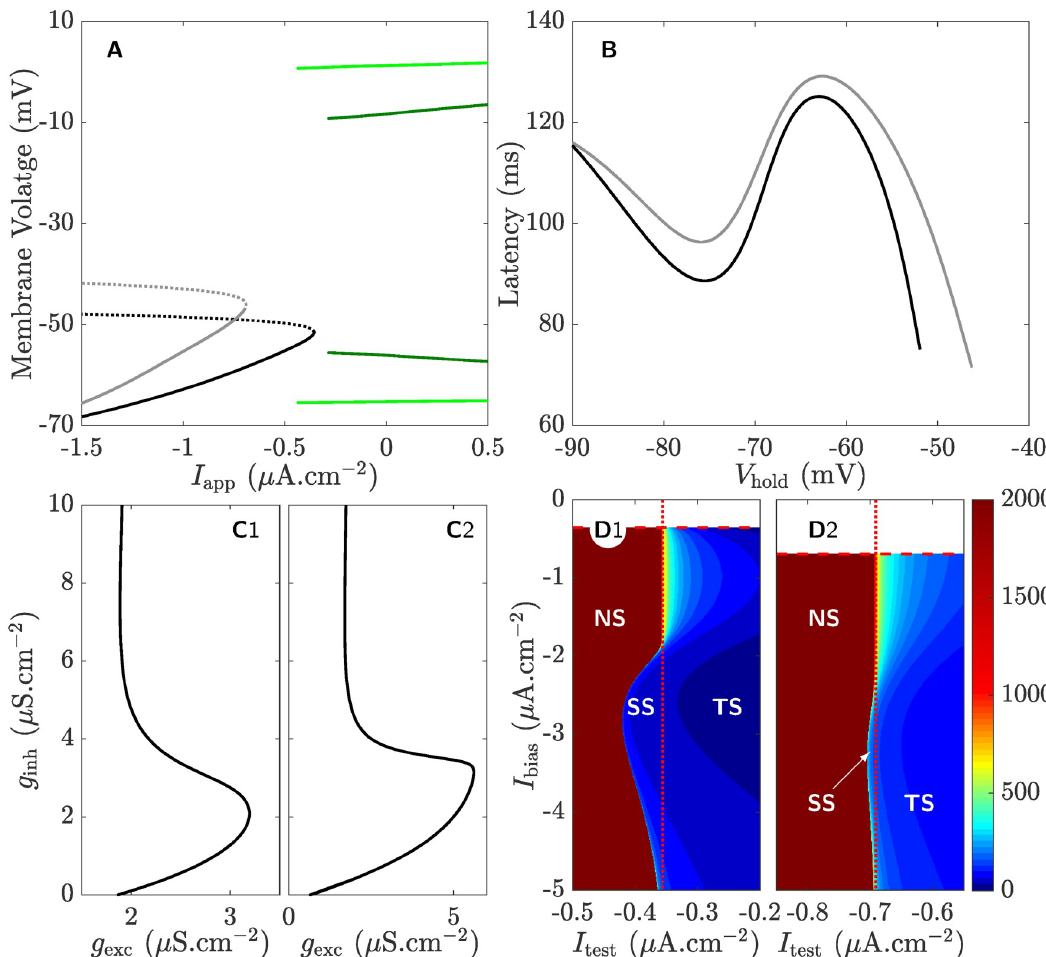
Fig 2. Review of the main four features of the full system (1): A ) Type I excitability with a SNIC bifurcation during pre- (faded lines) and post-runup (dark lines). Solid (dashed) black/gray lines correspond to branches of stable/unstable equilibria, respectively; solid green lines correspond to envelopes of stable limit cycles. B ) Non-monotonic first-spike latency with respect to the holding potential ( V hold ) during pre- (gray) and post-runup (back). C ) The boundary between responsive (to the right) and non-responsive (to the left) regimes when a pair of inhibitory and excitatory pre-synaptic inputs of various magnitudes are applied during pre- ( C 1) and post-runup ( C 2). D ) color-maps of the no-spiking ( NS ), single spiking ( SS ) and tonically spiking ( TS ) regimes during pre- ( D 1) and post-runup ( D 2), color-coded based on the duration of the first-spike latency calibrated according to the color-bar to the right. The system generates a single spike for I test < I SNIC when the stable manifolds of the saddle and saddle-node do not coincide and the initial condition lies between them. Time series simulations of these properties are available in [13, 16, 17].